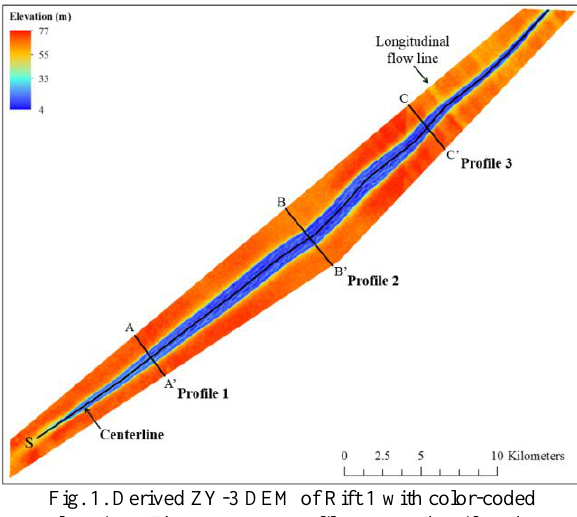
Fig. 1. Derived ZY-3 DEM of Rift 1 with color-coded elevations. Three traverse profiles across the rift and a centerline along the rift are shown as black lines. Mean width, depth and bottom elevation of the rift along with other key parameters were plotted against the distance along the centerline of the rift from the derived ZY-3 DEM. A specific measurement at a location is calculated by an average of the corresponding elevations over a transit line across the centerline. The rift surface is relatively flat with an average elevation of 72 m. The average rift floor depth is 48 m.